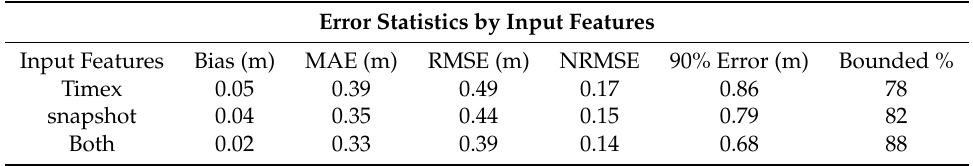
Table 1. The bias, mean absolute error, RMSE, depth-normalized RMSE, 90-th percentile error, and the % of offshore pixels bounded by the ensemble prediction for each of the three models by input features (timex only, snapshot only, timex + snapshot). Bounded % calculated using 0 mean and 0.05 standard deviation uniform noise of 100 ensemble members for the Gaussian Noise layer during inference